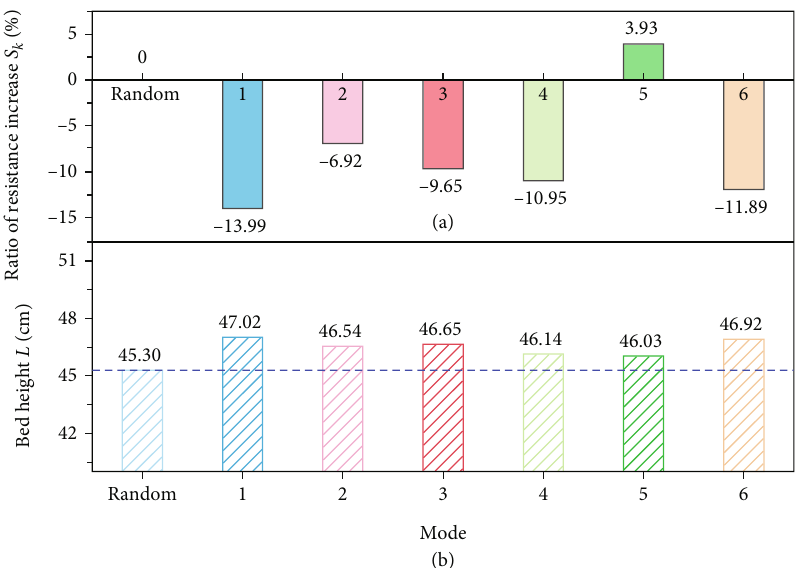
L (b) under di ff erent three-layer arrangement Figure 9: The ratio of the resistance increase S k (a) and the total height of the sinter bed modes for the sinter mixture with the equivalent particle diameter of